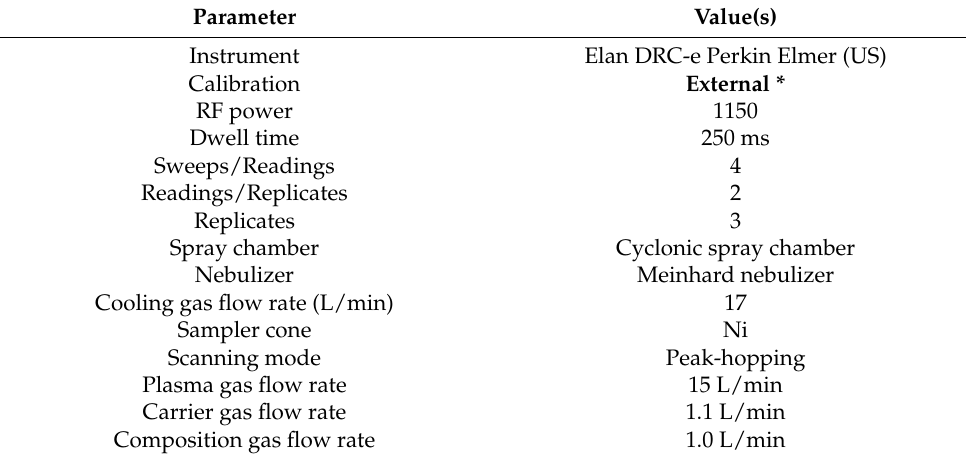
Table 2. ICP-MS operating conditions and